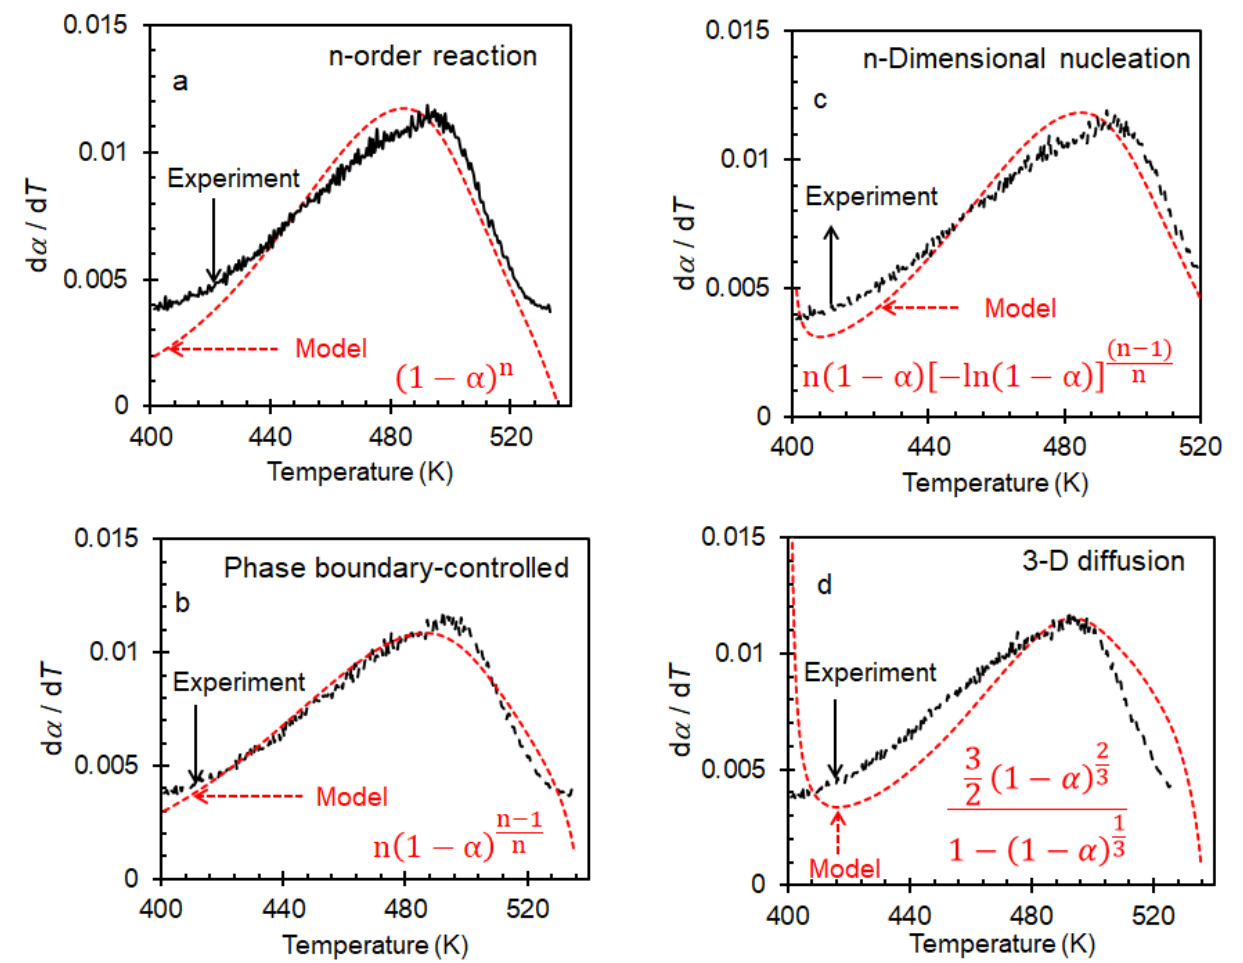
Figure 8. Fitted experimental data and calculated ( d α / dT ) using different reduction models (( a ) n -order reaction, ( b ) Phase boundary-controlled, ( c ) n -dimensional nucleation, ( d ) 3-D diffusion) for the second reduction step during TPR of 3.5% wt.% IrO 2 /TiO 2 (anatase, BET = 55 m 2 /g) with β = 10 °C/min.